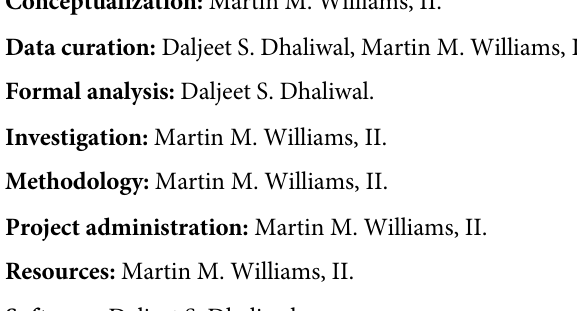
S1 Fig. Linear mixed effects models of plant density effects of a crowding stress tolerant hybrid on (A) ear number per plant, (B) average ear length (cm), and (C) filled ear